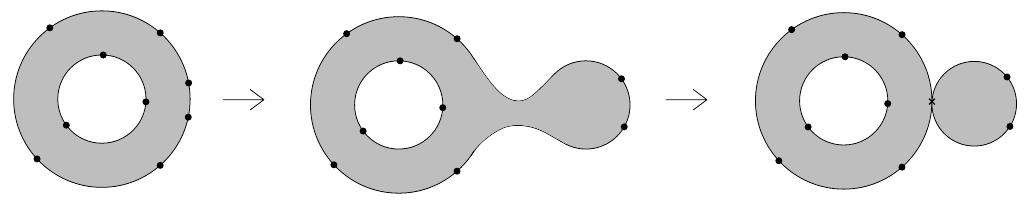
Figure 2 . Example of a separating degeneration at